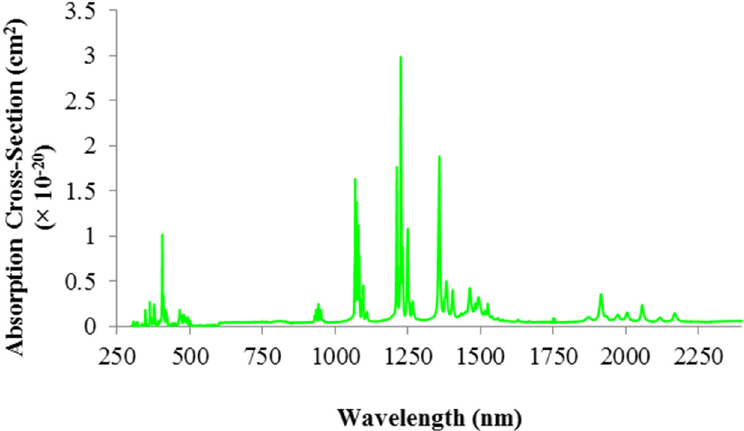
Figure 38. Absorption cross-section as a function of wavelength for a hydrothermally-grown Sm 3+ :YAG crystal at 298 K.